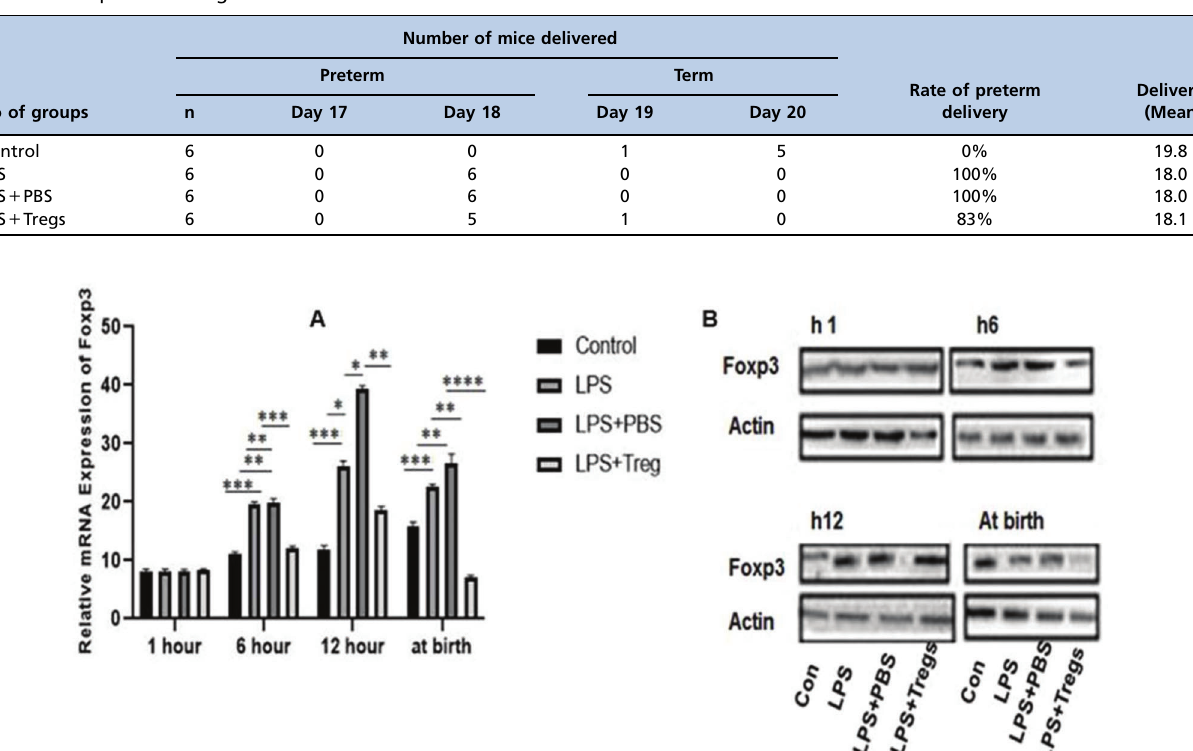
Table 3 - Response of Tregs in LPS-induced mouse model.